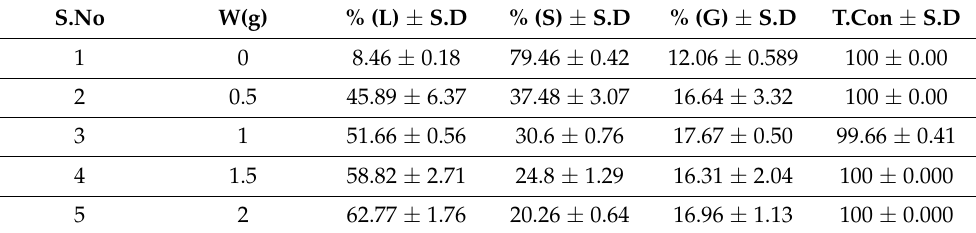
Table 2. Weight of Catalyst Optimization for Catalytic Cracking of Tube Rubber.